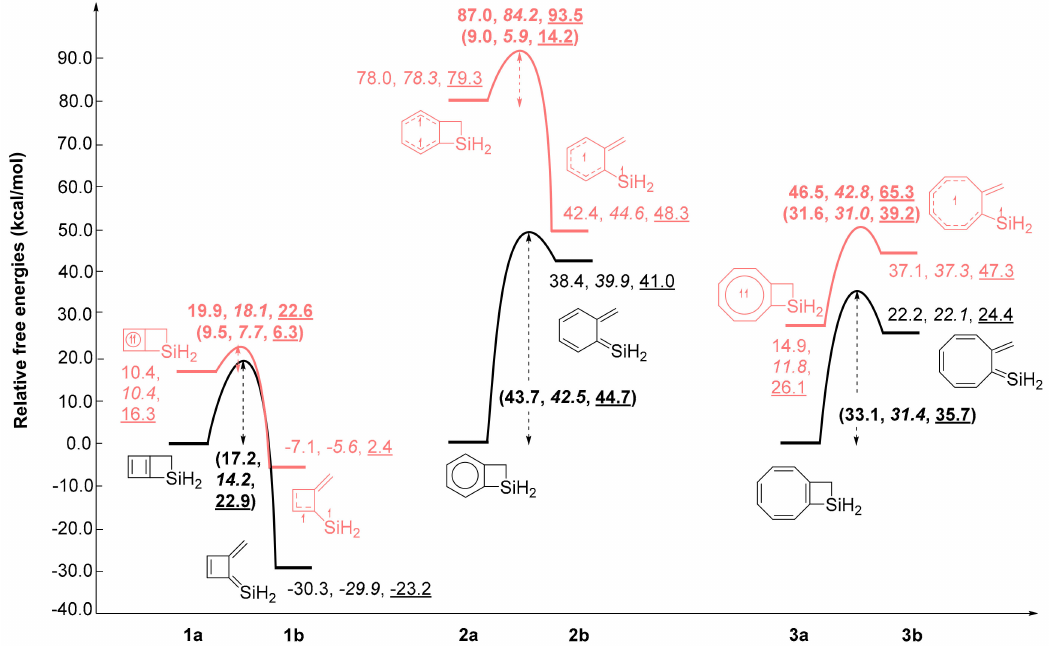
Figure 3. T 1 state potential free energy surface diagrams for ring-openings of 2,3-cyclobutadieno-1-SCB ( 1 ), 2,3-benzo-1-SCB ( 2 ) and 2,3-cyclooctatetraeno-1-SCB ( 3 ) at (U)B3LYP/6-311G(d,p) (normal print), (U)OLYP/6-311G(d,p) (italics), and (U)CCSD(T)/6-311G(d,p)//(U)B3LYP/6-311G(d,p) (underlined) levels. Values in parenthesis are activation energies. Values for the S 0 state in black and values for